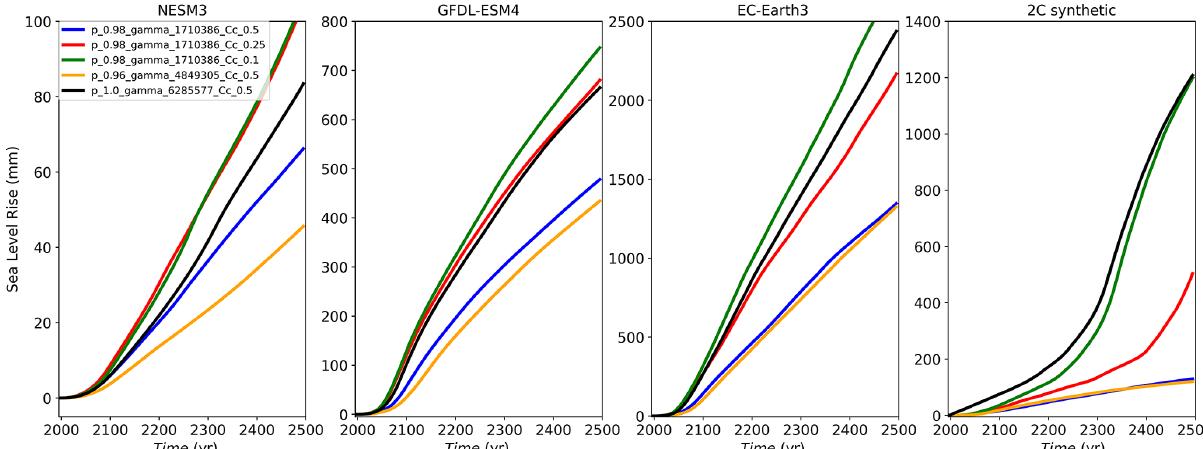
Figure A10. Sea level rise experiment using low (NESM3), moderate (GFDL–ESM4), and high (EC–Earth3) CMIP6 climate scenarios and 2 ◦ C synthetic experiment showing results using high p and low γ 0 values, with C c = 0 . 5 , 0 . 25 , 0 . 1 (blue, red, green, respectively) and high p , C c = 0 . 5, and mid/high γ 0 values (orange and black, respectively). The results show the following: (1) for fixed p and γ 0 , lower C c values lead to a stronger sea level response (the exceptional behavior seen with NESM3 might be due to the low and negative TF forcing in the Amundsen region); (2) for the three CMIP6 forced experiments, lowering C c by a factor of 5 is not enough to match sea level contribution produced by the spin-ups using higher γ 0 values; (3) in the 2 ◦ C synthetic experiment, the results with C c = 0 . 1 lead to similar sea level response compared with the experiment with high γ 0